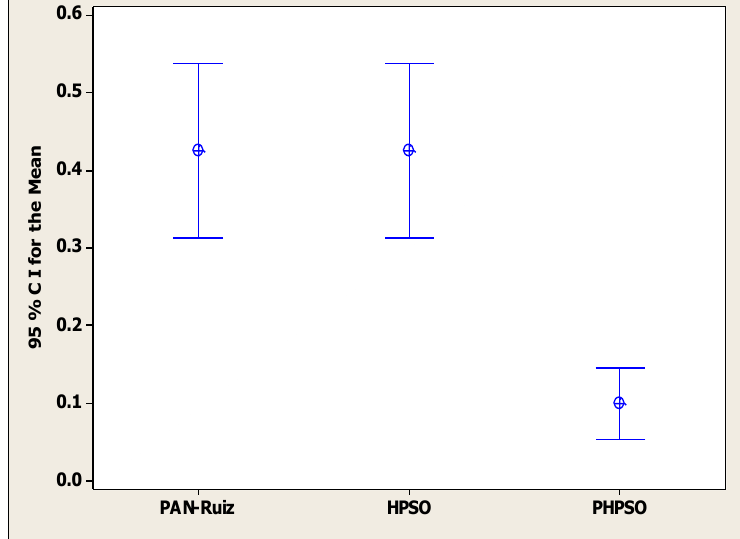
Figure 2. Means and 95% confidence intervals for different algorithms for ta001 to ta120.